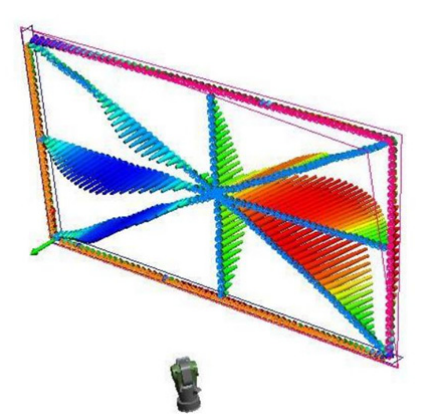
Fig. 9 Results of Onset Buckling Scan of Physical Test as Shown Through Spatial